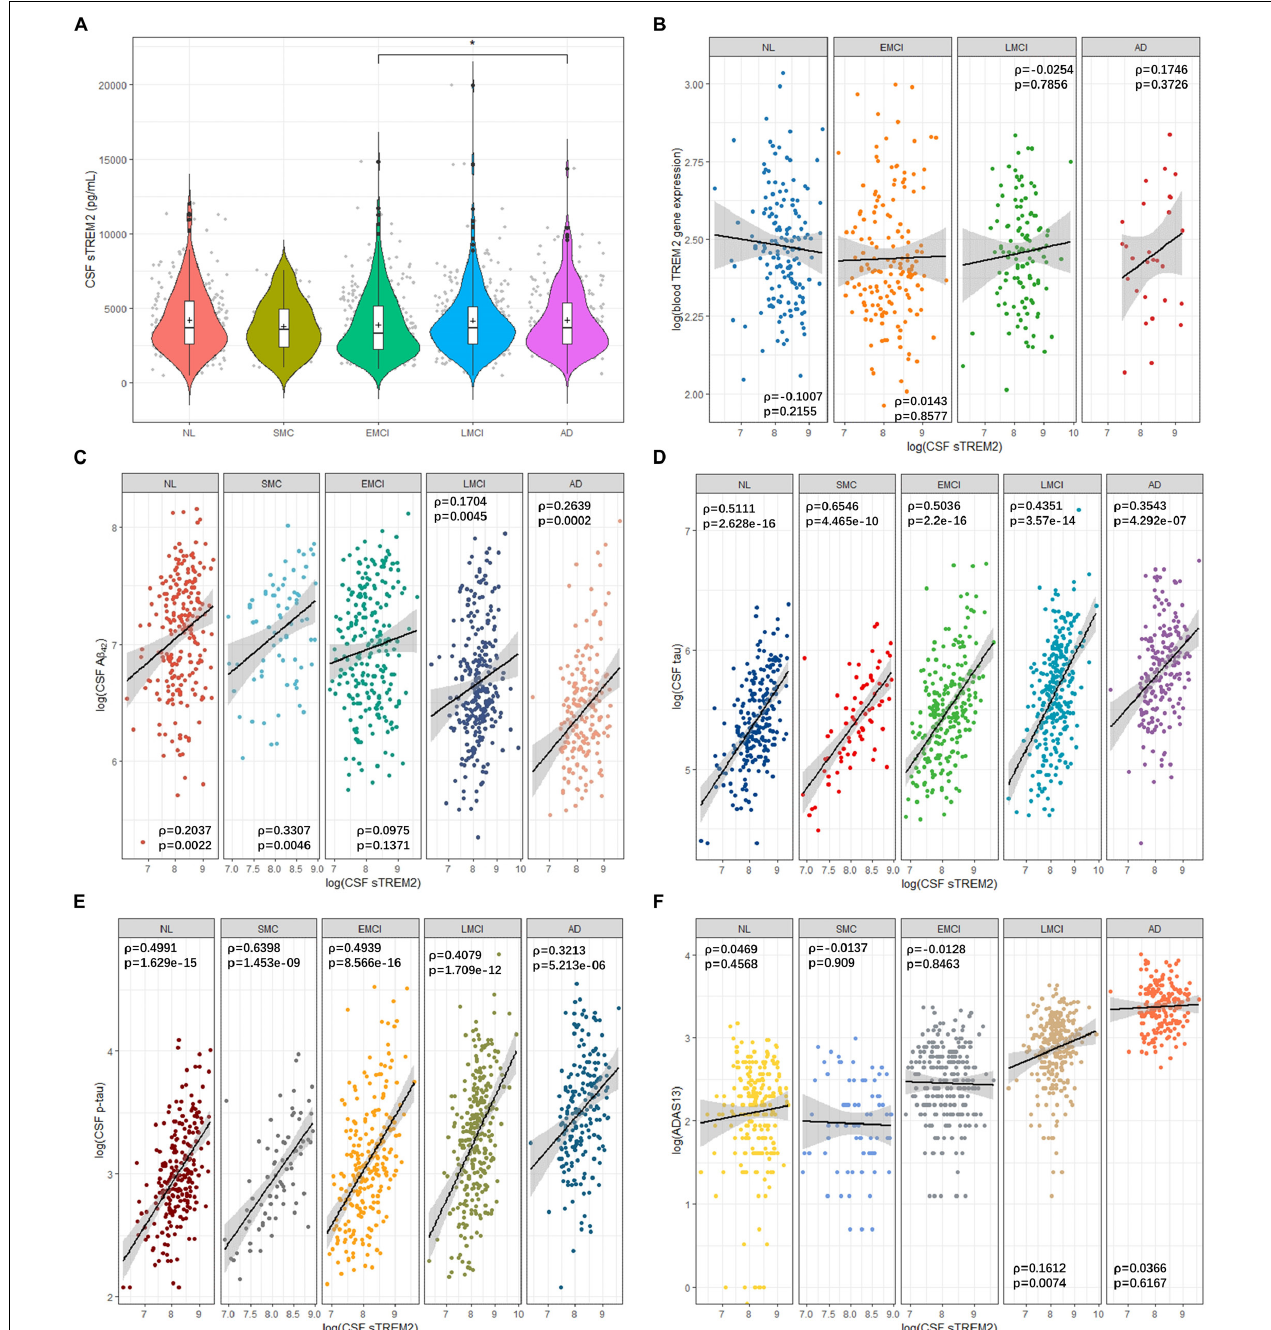
FIGURE 1 | Cerebrospinal fluid sTREM2 levels in the five clinical disease stages and the correlation between sTREM2 and other AD biomarkers. (A) Violin plots with boxplots for the comparison of CSF sTREM2 levels in disease states. Statistical significance was determined by Wilcoxon rank sum test. +: mean. ∗ p < 0.05. The correlation plots between log transformed CSF sTREM2 and (B) log transformed TREM2 gene expression in blood samples, (C) log transformed CSF A β 42 , (D) log transformed CSF tau, (E) log transformed CSF p-tau, and (F) log transformed ADAS13 scores for each group. Black straight lines are the regression lines. Shaded areas around regression lines represent the pointwise 95% confidence intervals (CI). ρ : Spearman’s rank correlation coefficient (rho).